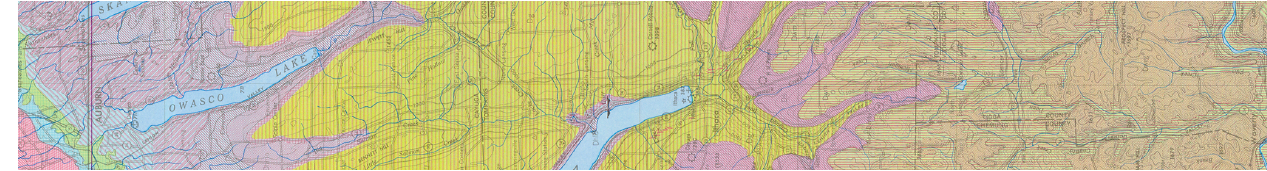
Figure 1. Bedrock geology of central New York state, with the transect from 43 (left) to 42 ◦ N and centred on − 76 ◦ 30 (cid:48) E. The orientation is north (left) to south (right). The chronological and topographic sequence from Upper Silurian (N) through Upper Devonian (S) sedimen- tary rocks, notably the Onondaga limestone (green, Don) and Tully limestone (crosshatched red, Dt) are shown (Source: New York State Geological Survey, 1970).